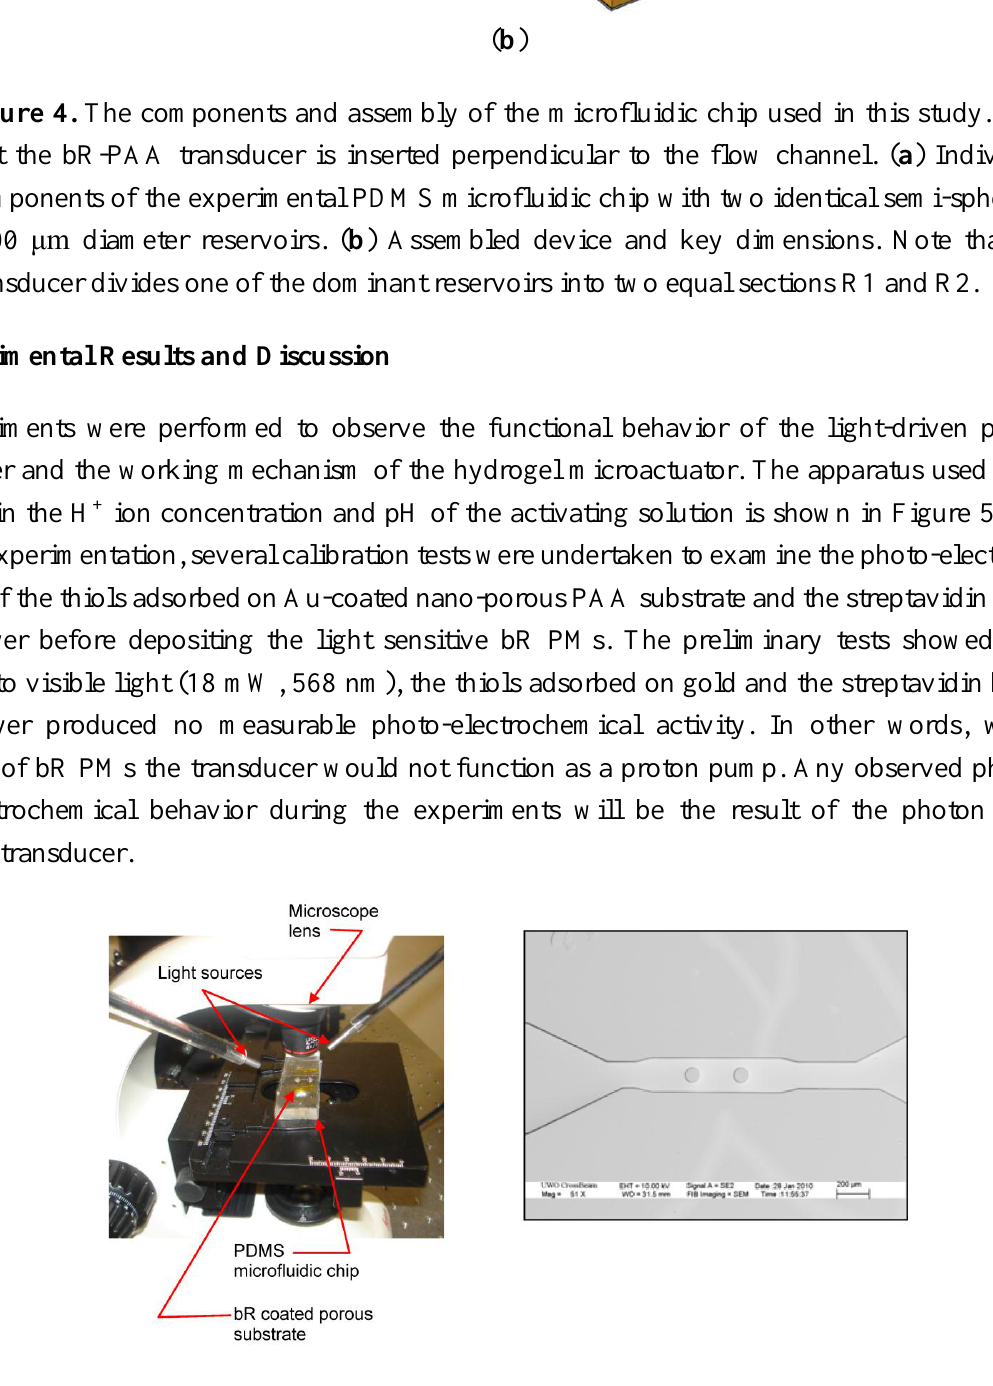
Figure 5. Experimental apparatus used to measure the changes in pH of the ionic solution and observe swelling/deswelling of the hydrogel microactuator. A close-up view of the microchannel on the experimental PDMS microfluidic chip is shown on the